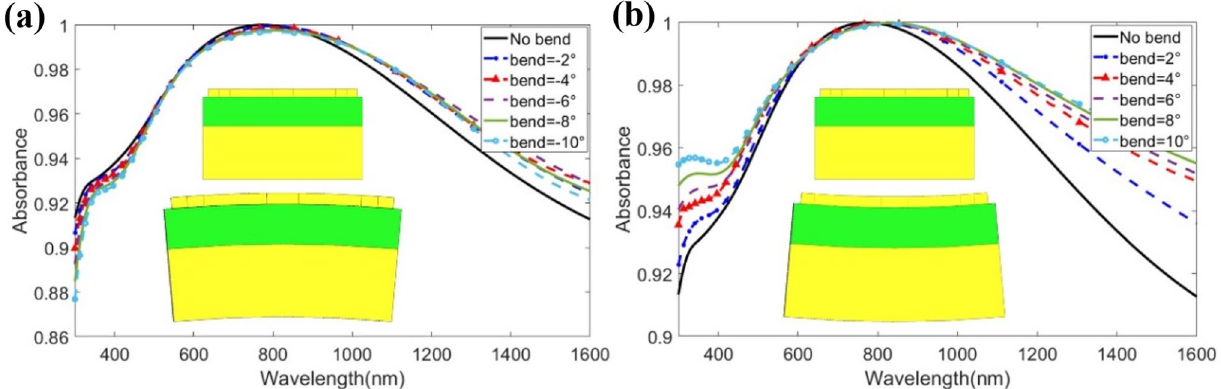
Figure 10. Absorption phenomenon of the proposed structure under ( a ) negative/convex bending from 0° to 10°, and ( b ) positive/concave bending from 0° to 10°. Insets: ( a ) representation of negative bending with θ degree, and ( b ) positive bending with θ degree.